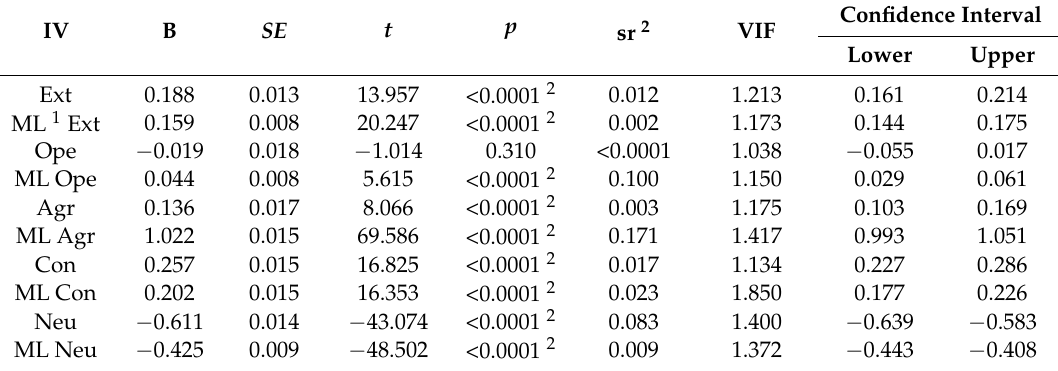
Table 4. Multiple Linear Regression Model of observed FFM traits on SWB and of machine learning-derived FFM traits on the machine learning-derived SWB ( n = 13,497) after matching predicted values with gender and